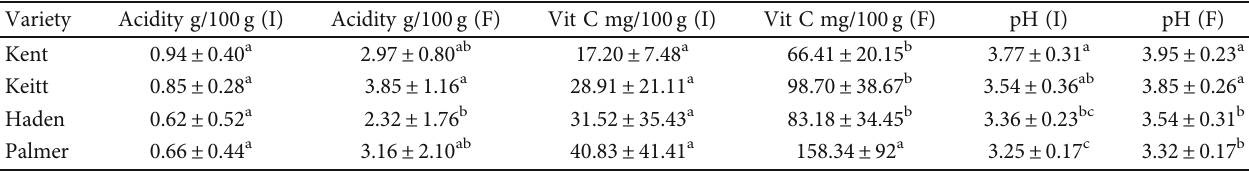
Figure 7: Model fi tting for Kent, Keitt, Haden, and Palmer varieties at 55 ° C, 65 ° C, and 75 ° C. Table 3: Chemical and nutritional properties of four mango